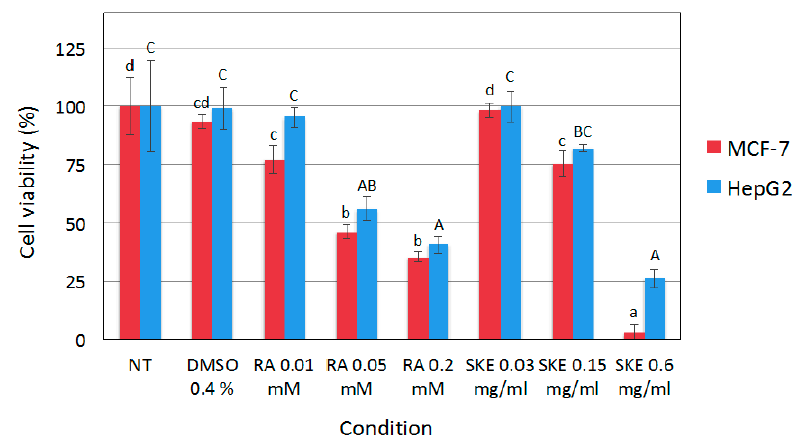
Figure 4. E ff ect of S. khuzistanica extracts on viability of MCF-7 and HepG2 cells. Cell viability